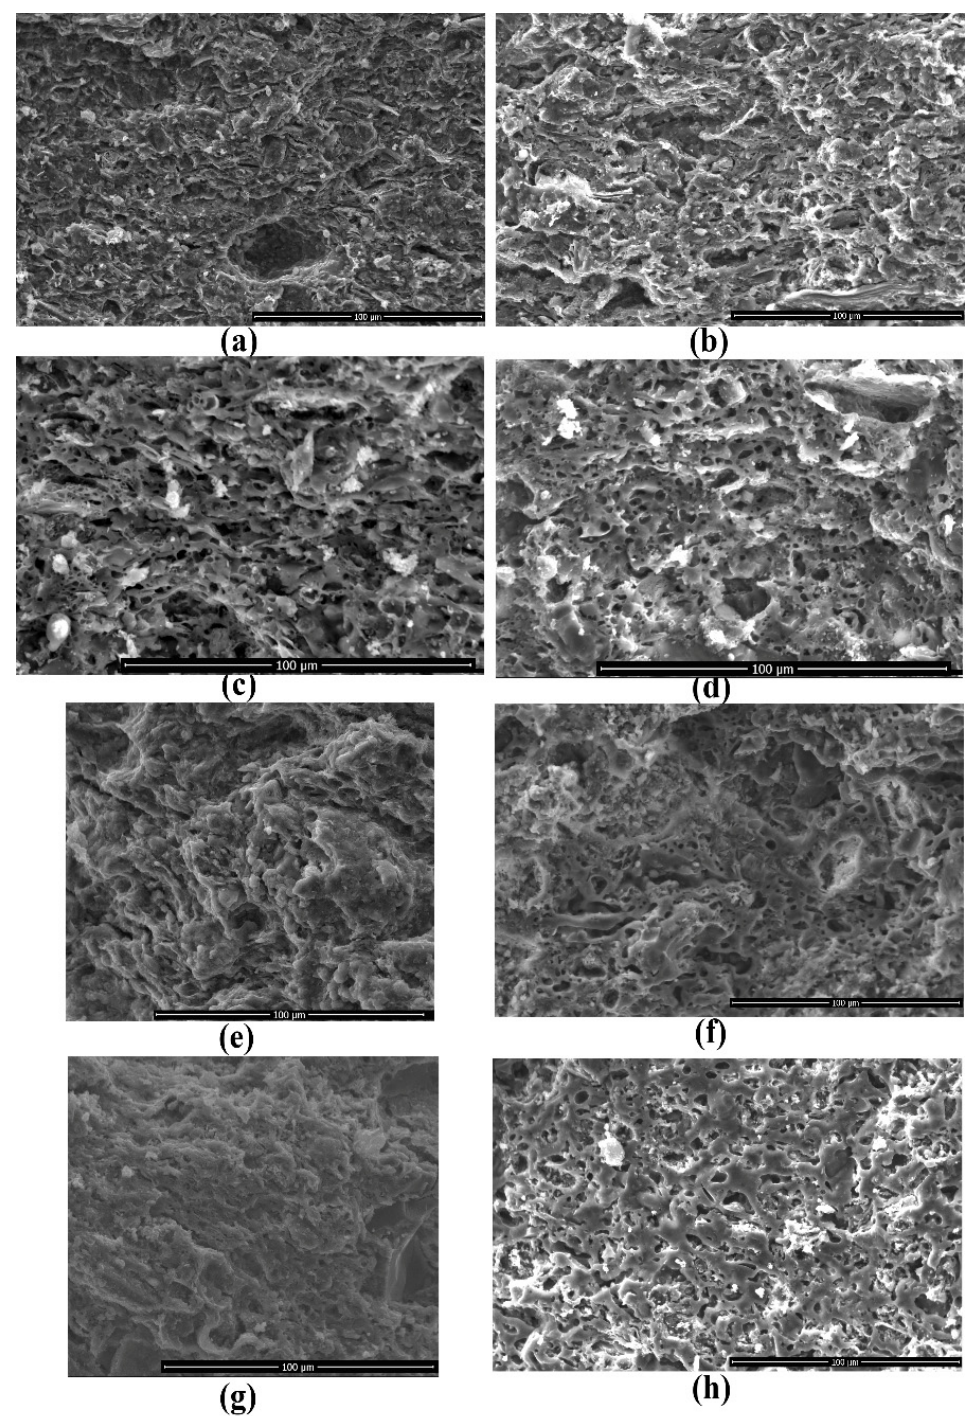
Figure 13. SEM photomicrograph (SE) of some of the archaeological individuals discussed. Chemical group CGHIM01: ( a ) HIM099, F1, NV microstructure; ( b ) HIM091, F2, V microstructure; ( c ) HIM075, F3, V+ microstructure; ( d ) HIM178, F4, TV microstructure. Chemical group CGPAR01: ( e ) PAR002, F1, NV microstructure. Chemical group CGPAL01: ( f ) BAD007, F1, V microstructure. Chemical group CGPAL02: ( g ) PAR004, F2, IV microstructure; ( h ) HIM174, F4, TV microstructure. Photomicrograph taken at ×2000, except for ( c , d ) at ×1000 taken with a JEOL J6510. The second group related to Palermo, CGPAL02, is the second-largest group identified in this study, formed by 31 individuals. Their diffractograms show up to eight fabrics indicating a wide range of EFT from <800 °C to >950/1000 °C (Table 4). The F1